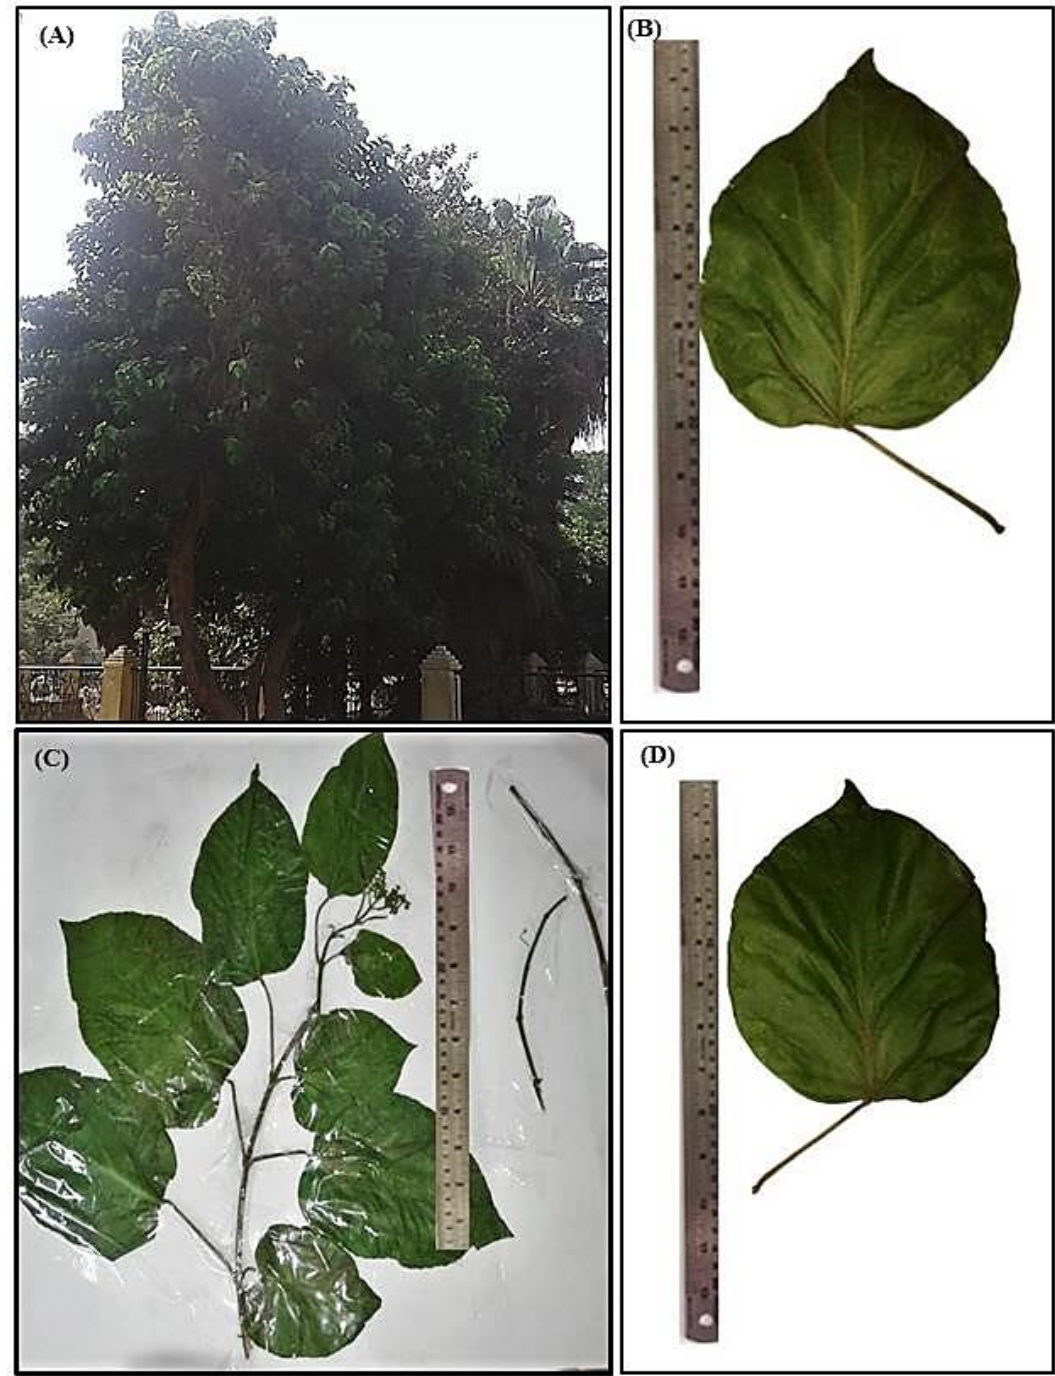
Figure 1. Morphological characterization of P. odorata displaying ( A ) entire tree, ( B ) leaf lower surface (× 0.25), ( C ) leafy branch (× 0.17) and ( D ) leaf upper surface (× 0.25).